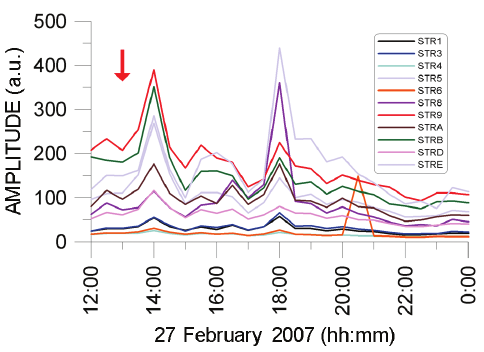
Fig. 10. The seismic amplitude in the hours follow- ing the beginning of the effusive phase (marked by the red arrow). Note the two episodes of volcanic tremor increments at about 14:00 and 18:00.